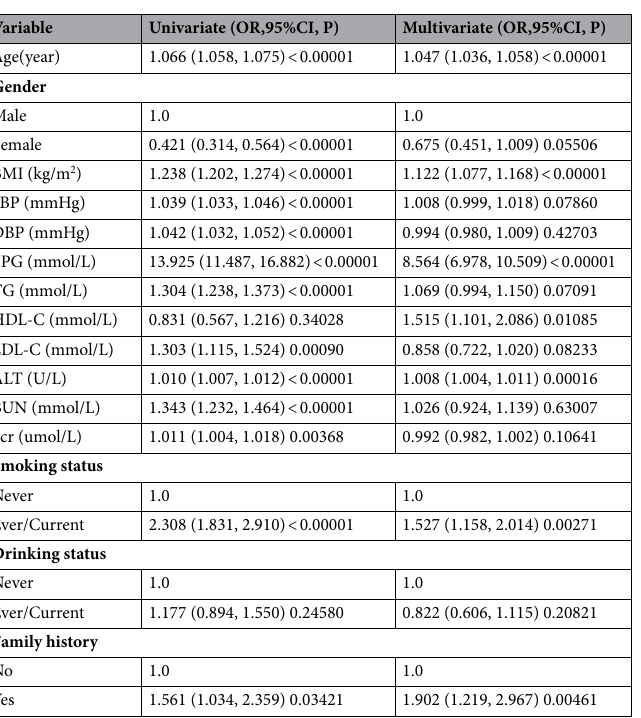
Table 3. Risk predictors for incident diabetes in the univariate and multivariate analysis. BMI, Body mass index; SBP, Systolic blood pressure; DBP, Diastolic blood pressure; FPG; Fasting plasma glucose; TG, Triglyceride; HDL-C, High-density lipoprotein cholesterol; LDL-C, Low-density lipid cholesterol; ALT, Alanine aminotransferase; BUN, Blood urea nitrogen; Scr, Serum creatinine; Family history, Family history of diabetes. OR, Hazard ratios; CI, Confidence interval; Ref,